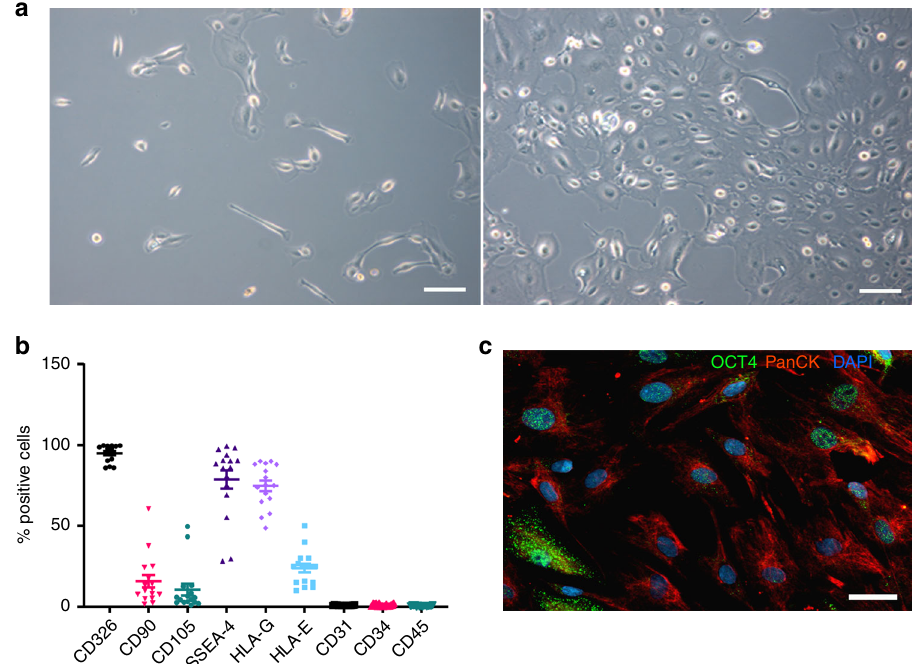
Fig. 1 Characterization of hAECs. a Phase-contrast microscopic images of cultured hAECs at days 2 (left panel) and 5 (right panel) after seeding. Scale bar = 100 μ m. b hAECs were characterized for various surface markers by FACS. Data are the means ± SEM, of cells obtained from sixteen different donors labeled with speci fi c antibodies (% positive cells). c Immunohistochemical detection of cytokeratin (red) and OCT-4 (green) in cultured hAECs; nuclei are labeled by DAPI (blue). Scale bar = 50 μ